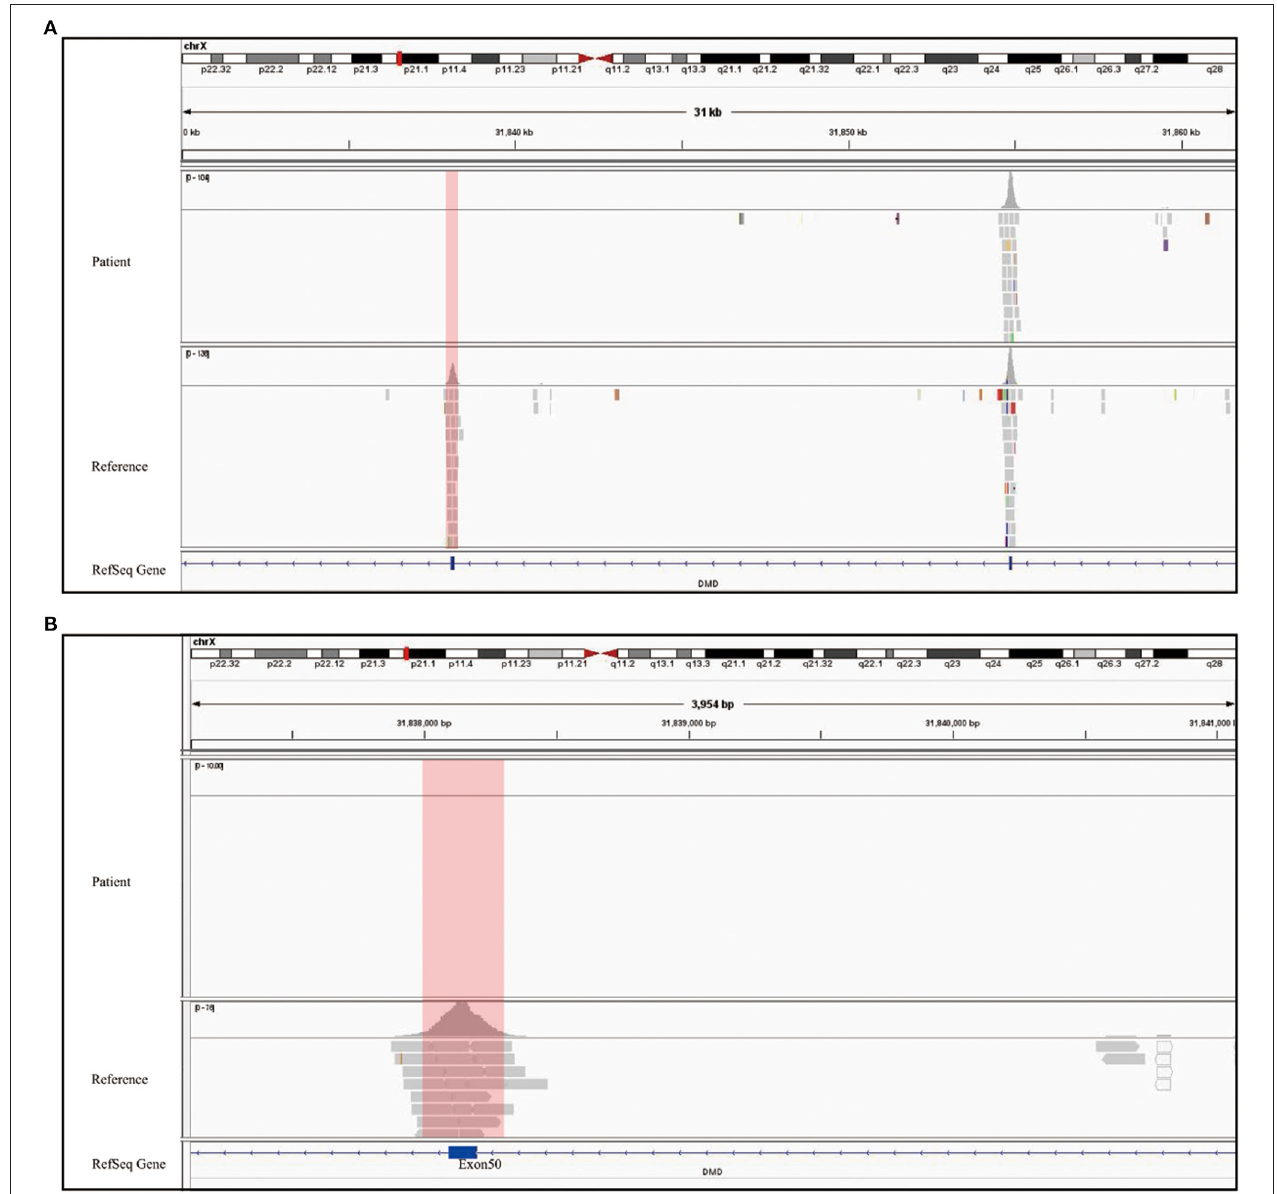
FIGURE 3 | Genetic test report of SMA and DMD. (A) MLPA report shows 0 copy of exons 7 and 8 of SMN1 , 3 copies of exons 7, and 8 of SMN2 . The left arrow refers to SMN1 exons 7 and 8, and the right one refers to exons 7 and 8 of SMN2 . The blue region represents the SMN1 probe, SMN2 probe, and SMN1 + 2 probe shown on the top of the diagram. The gray region shows the reference probe on different chromosome. All data were normalized by the reference and standard, which contains two copies of SMN1 and SMN2. Therefore, the Y axis is the ratio compared to standard’s copy number. (B) The two report together presented a whole exon detection of DMD gene, and B1 only showed homozygous deletion in exon 50 while other exons are one copy. There is no copy number variant shown in B2. The blue region refers to exons 1–79 of the DMD gene , and the gray one refers to the reference probe for